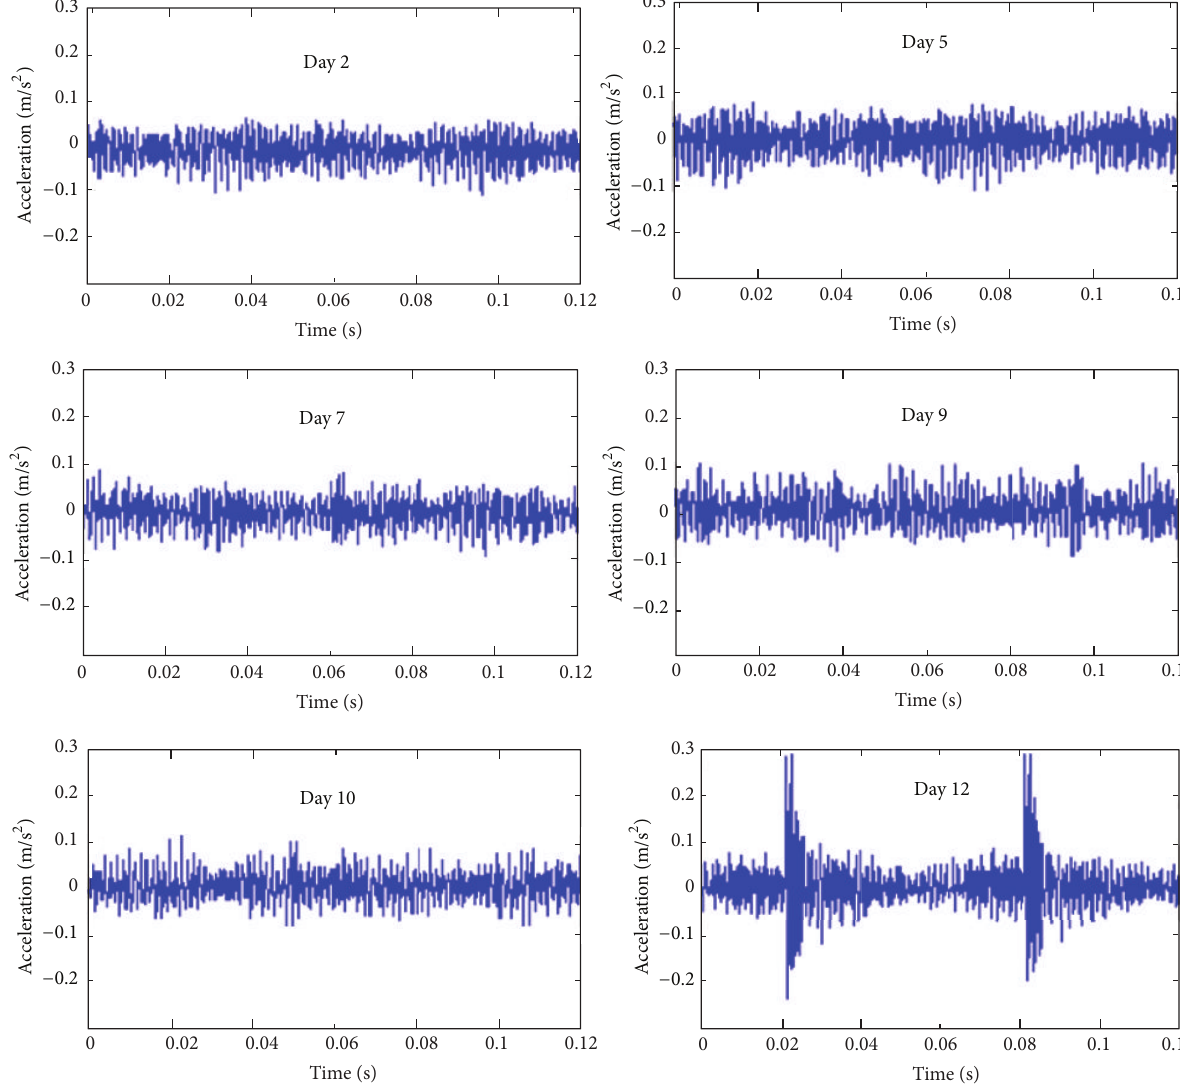
Figure 17: Evolution of acceleration signal with